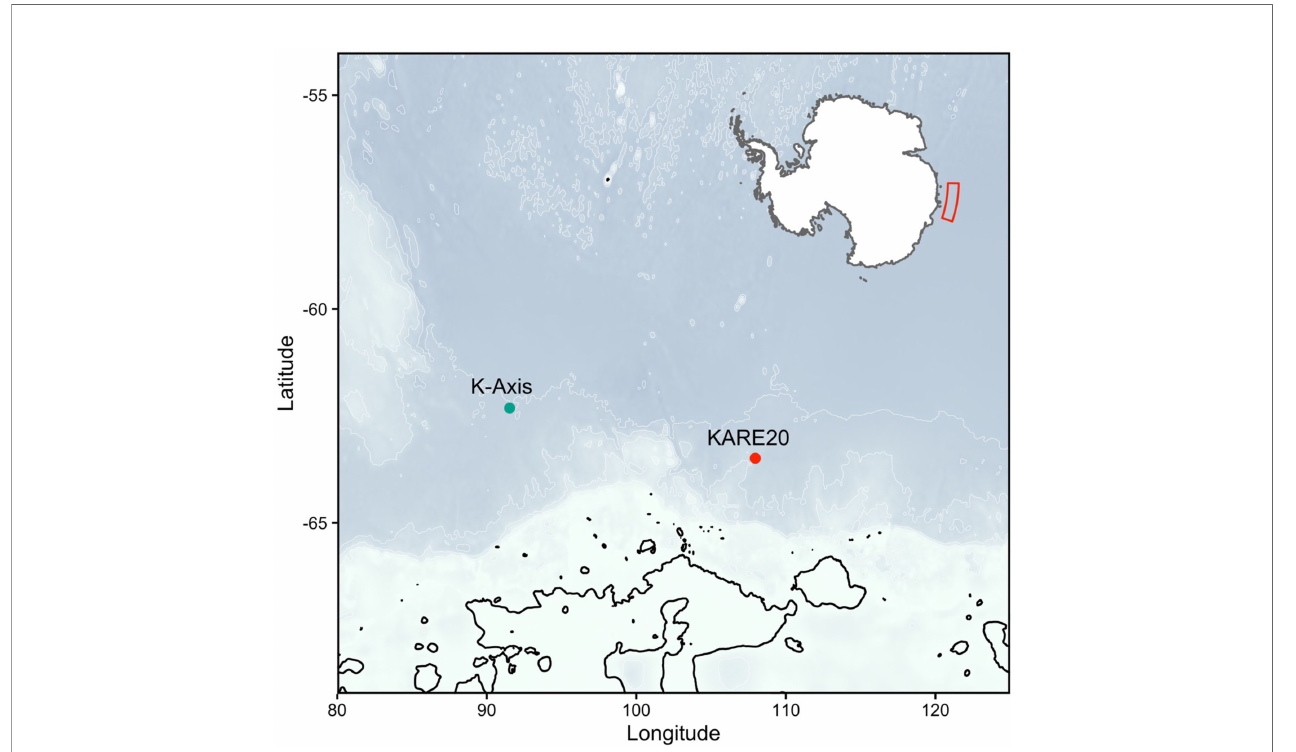
FIGURE 1 | Map of two sampling stations representing two separate research voyages aboard the TRV Umitaka-maru (KARE20) and the RV Aurora Australis (KAXIS), surveyed during the 2017 and 2016 austral summer,